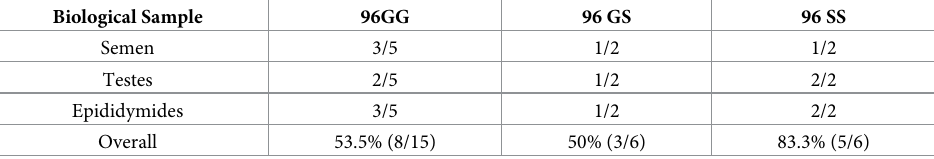
Samples were declared as positive in PMCA if at least two of the triplicates gave a protease-resistant PrP Sc signal in any of the PMCA rounds